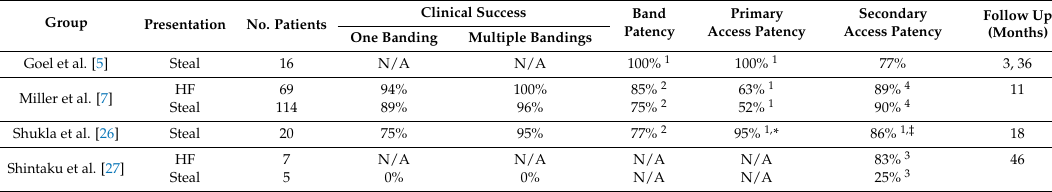
Table 1. Comparison of available MILLER procedure